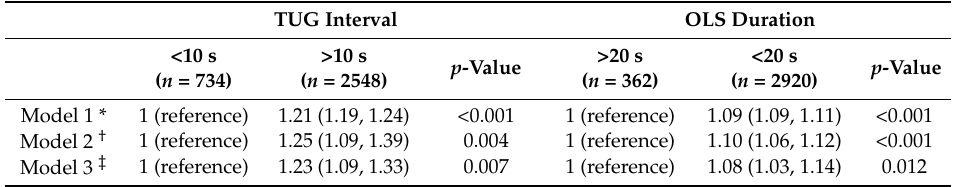
Table 4. The effect of lower limb function on the risk of a cognitive disorder.